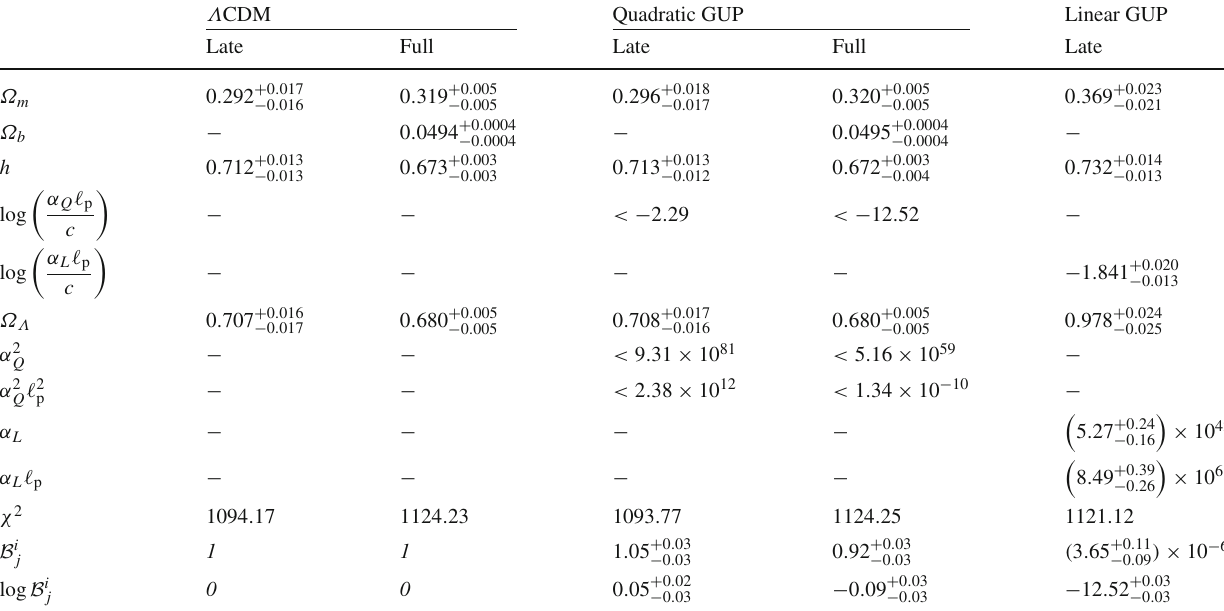
Table 2 Results of our analysis at 1 σ confidence level Λ CDM Quadratic GUP Linear